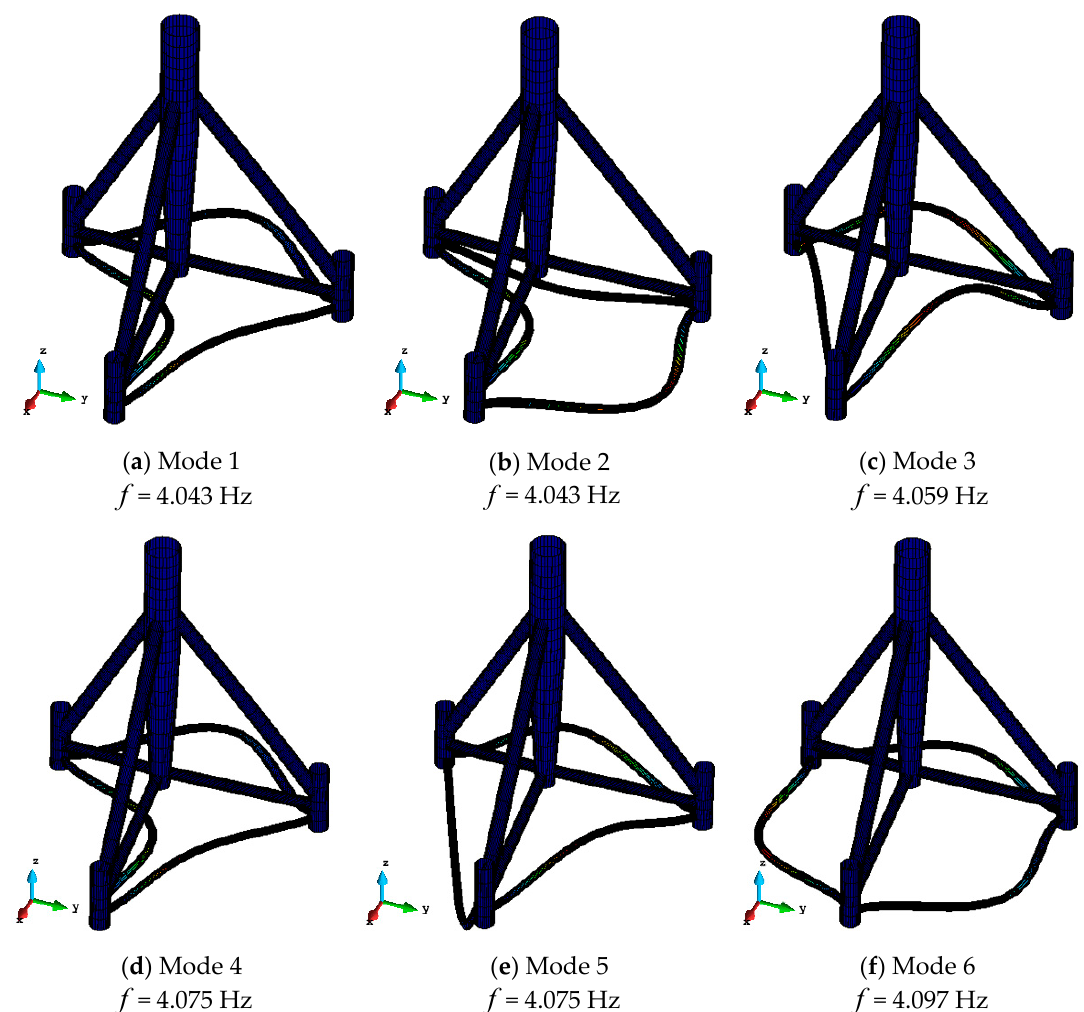
Figure 13. Natural frequencies and mode shapes of the tripod support structure.